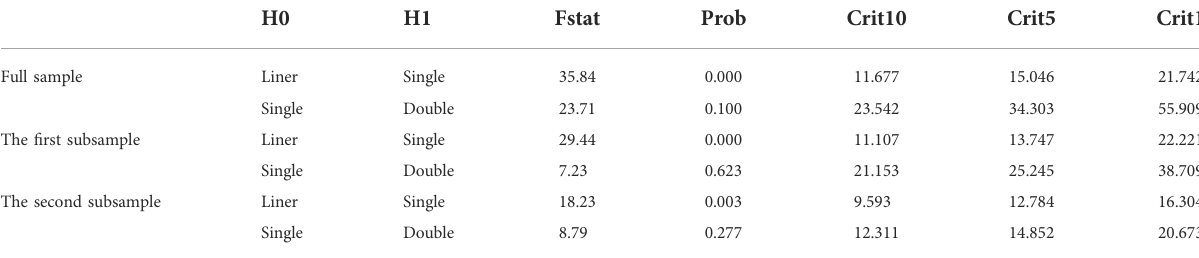
TABLE 5 Threshold effect test of investor sentiment.